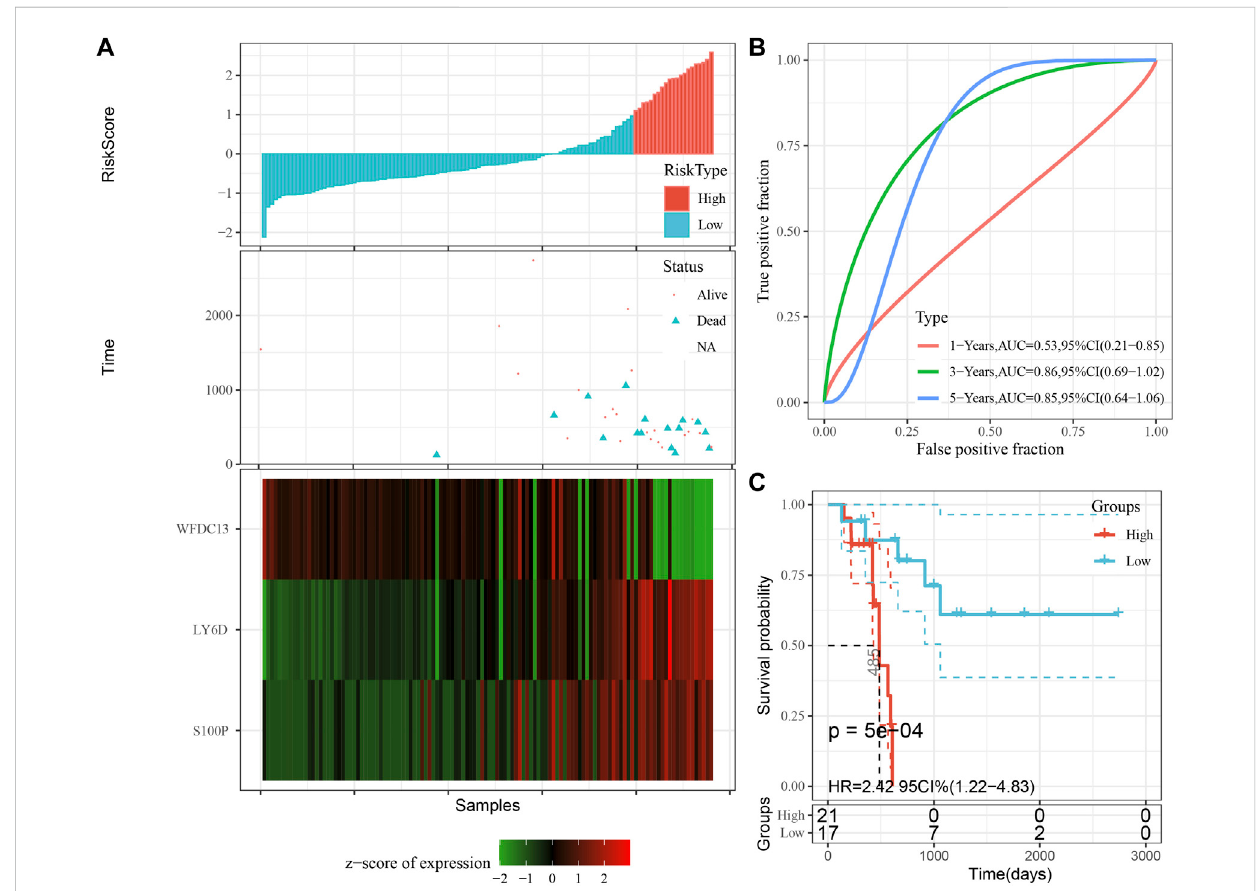
FIGURE 9 Validation of the prognostic gene signature in validation set. (A) Risk score, survival time and survival status and expression of the 3 genes. (B) ROC curve and AUC of the 3-gene signature classi fi cation. (C) Distribution of KM survival curves of the 3-gene signature in the validation